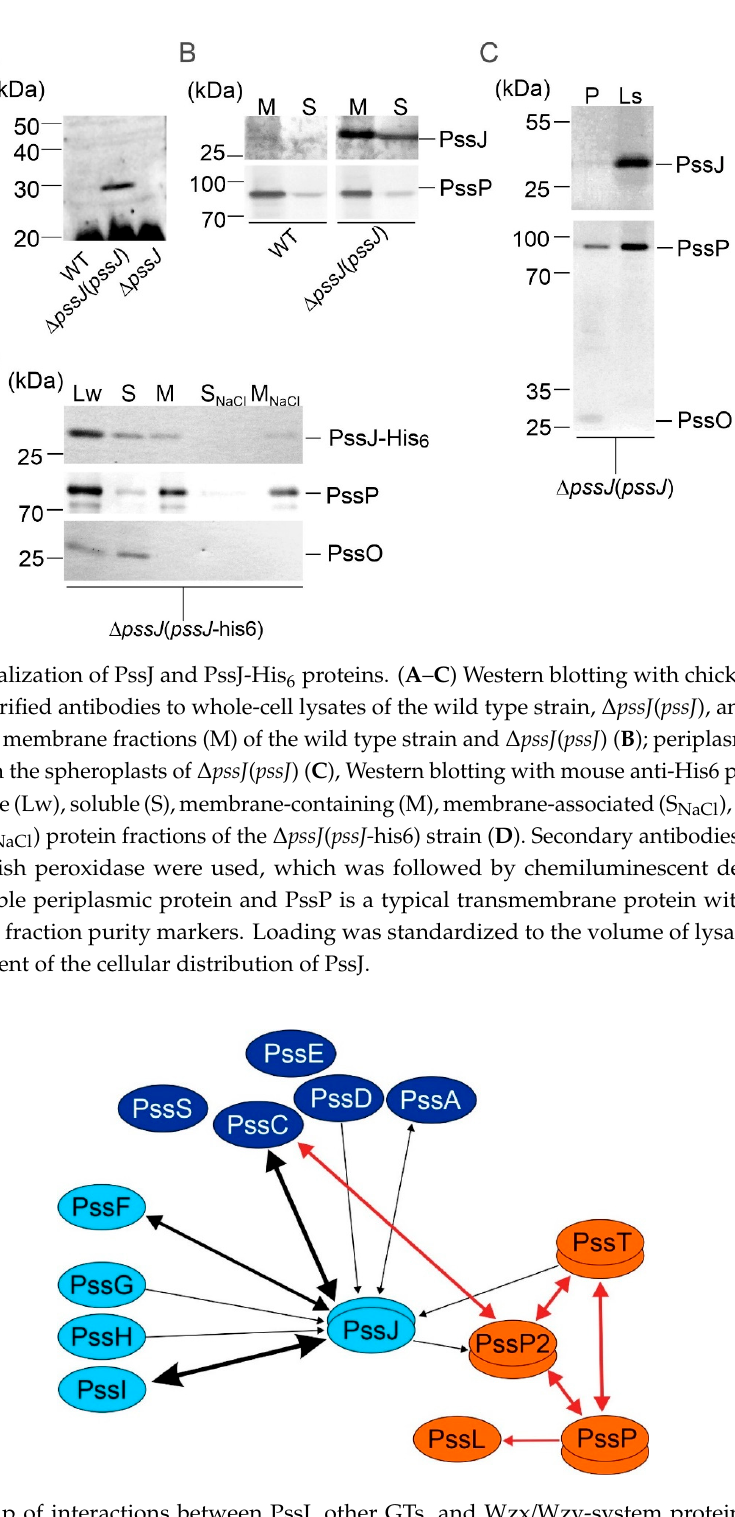
Figure 11. Map of interactions between PssJ, other GTs, and Wzx/Wzy-system proteins based on the bacterial two-hybrid results. Proteins in dark blue—GTs involved in the transfer of sugars in the main chain of the subunit; proteins in pale blue—involved in the synthesis of the side chain, and orange—flippase PssL, co-polymerases PssP/PssP2, and polysaccharide polymerase PssT (colors match those in Figure 1). The thickness of the line linking the two proteins represents the number of “positives” identified in 4–8 combinations of co-transformed plasmids encoding GTs and other Pss proteins. The arrows point towards bait proteins expressed from the pUT18/pUT18C plasmids. Black lines—interacting pairs identified in this work; red lines—interacting pairs identified in previous works [37,41].